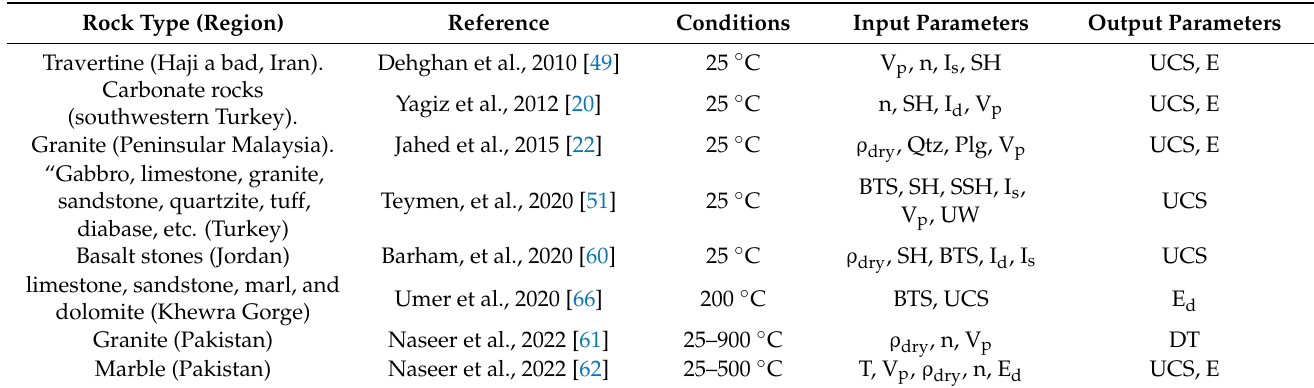
Table 1. Summary of some recent related studies in various